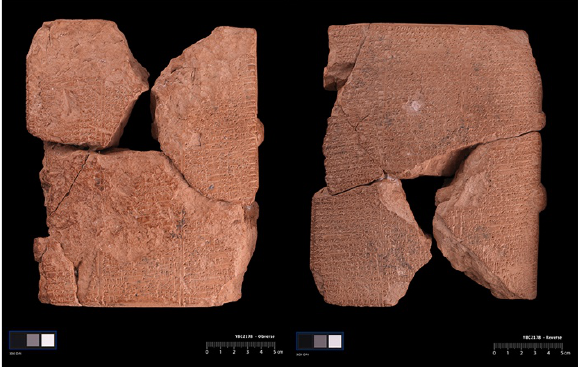
Figure 1. High-resolution photographs of the obverse and reverse of YBC 2178. (credit: Yale Babylonian